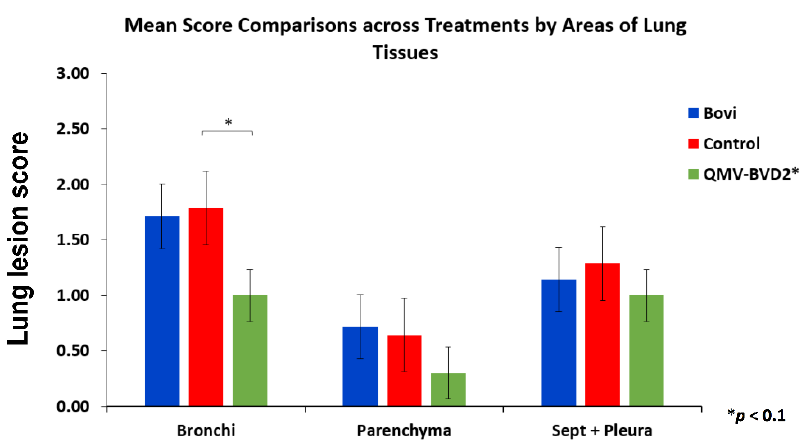
Figure 15. Mean histopathology–lesion scores across treatment groups by areas of lung tissues. Note that a significant difference was detected between the QMV–BVD2* and control groups in Bronchi (* p < 0.1). In other words, QMV–BVD2*(M = 1, SD = 0.67) protected the calves significantly better from the lung lesions after the BVDV–2 challenge when compared to the calves in the control group (M = 1.76, SD = 1.12).